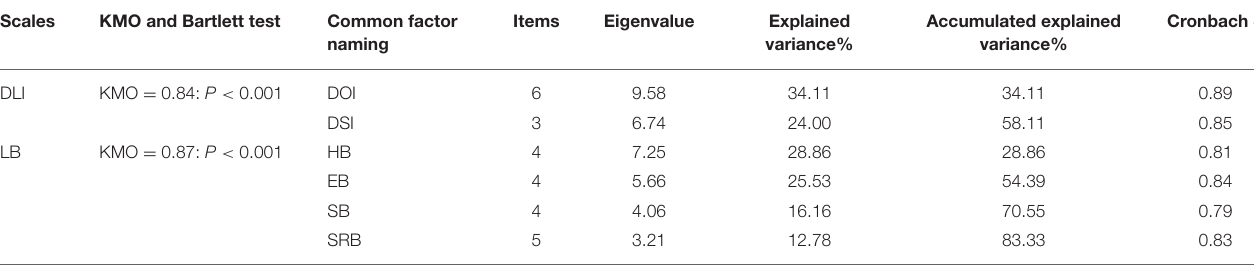
TABLE 1 | Extraction of common factors and reliability analysis of leisure involvement and leisure benefit scale in Northern Guangdong. Scales